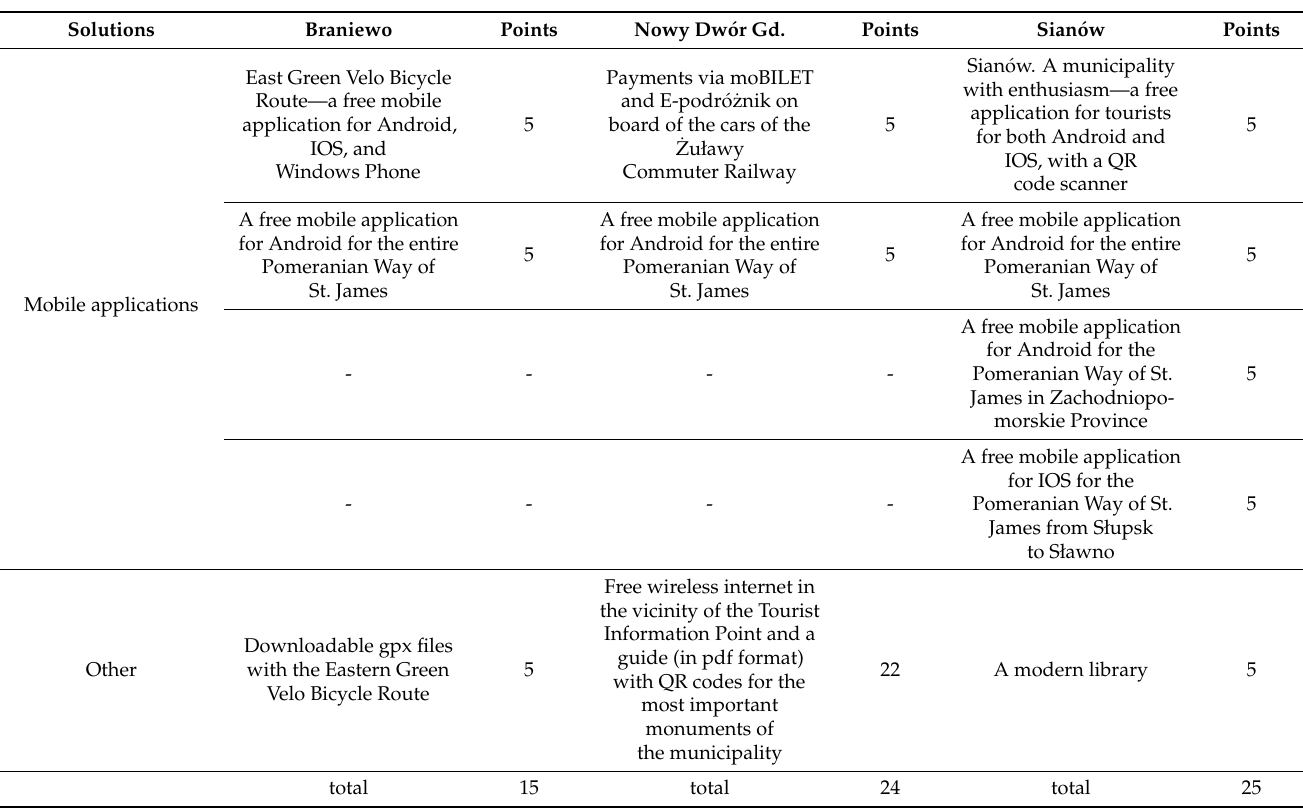
Table 11. A list of solutions that implement modern technologies in a manner that emphasizes the cultural qualities of the town. Solutions Braniewo Points Nowy Dw ó r Gd. Points Sian ó w Points